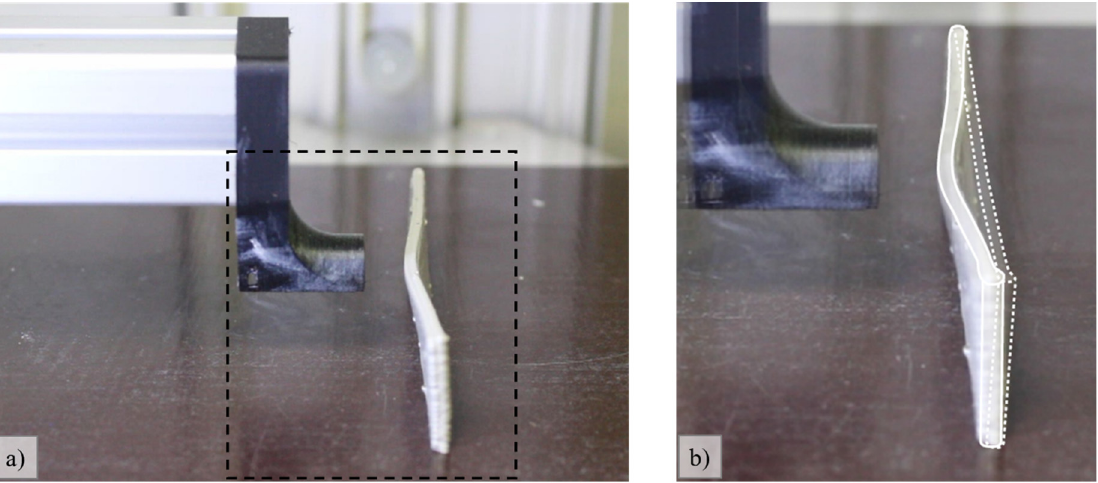
Figure 12. Deformation of the wall: (a) by a permanent magnet and pulsating movement (without laser sensor); (b) schematic comparison to the initial position. laser sensor); ( b ) schematic comparison to the initial